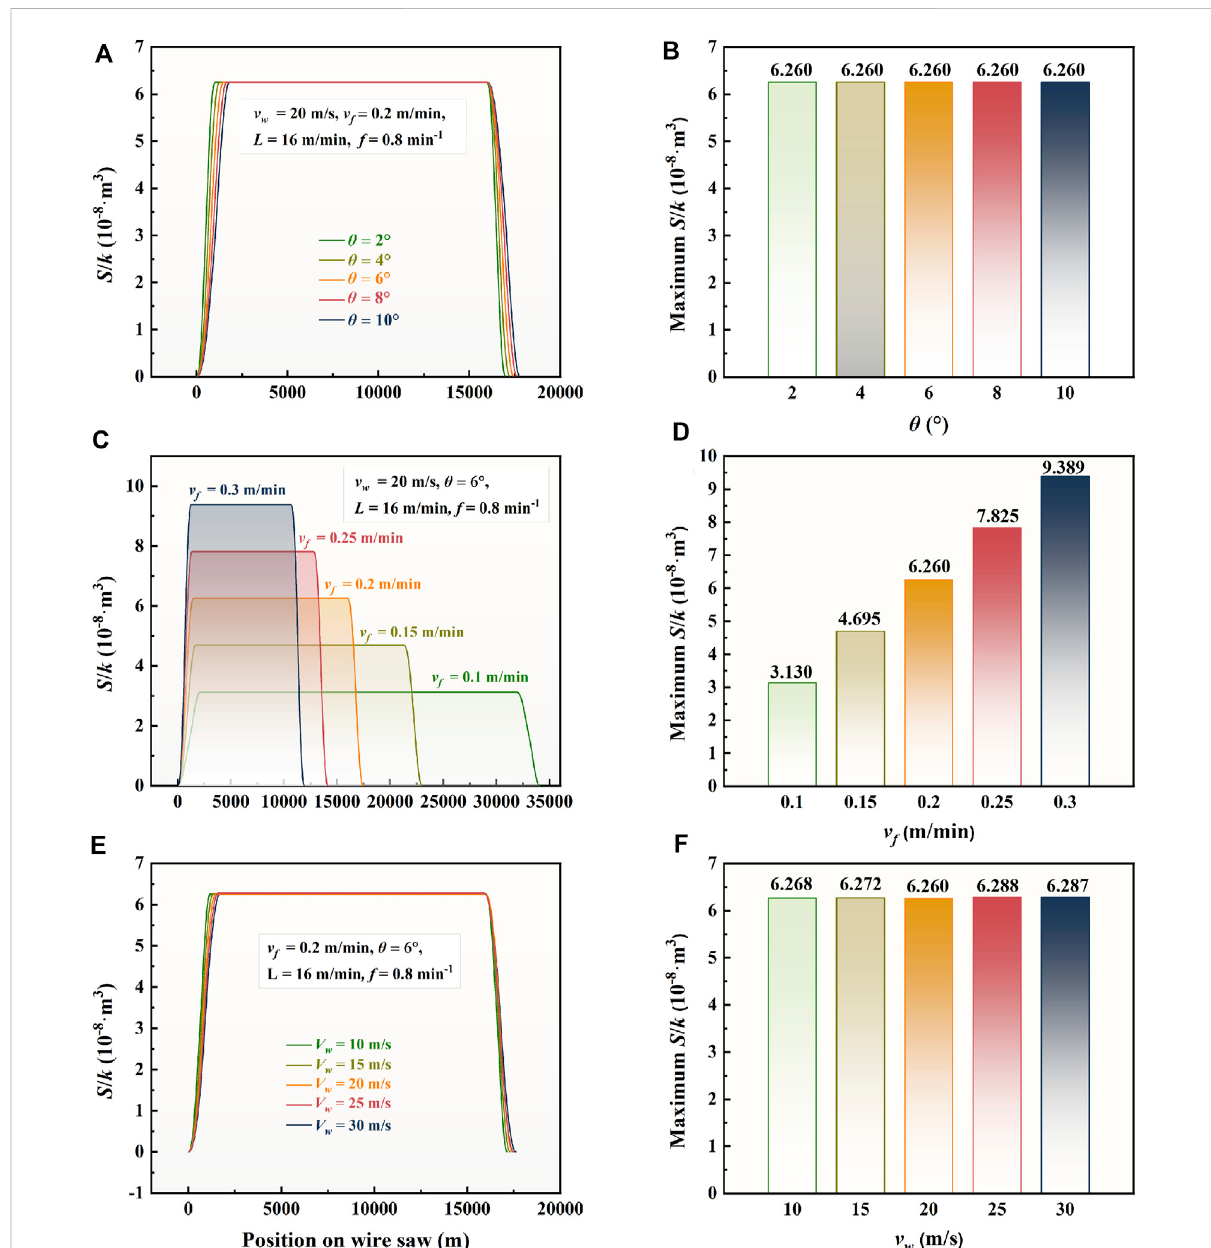
FIGURE 10 Variation of the wear amount of the wire saw on the rectangular workpiece under different maximum rocking angles, workpiece feed speeds and maximum wire speeds. Figure (A,B) illustrate the effect of the rocking angle on the maximum wear of the wire saw is not obvious, because the change ofthe angle isnot obvious to thechangeof thesawing area ineach cycle. Figure (C,D) illustrate thechange of theworkpiece feed speed has obvious changes to the maximum wear amount of the wire saw. This is because the change in the workpiece feed speed will cause the sawing area to follow the change in each cycle. Figure (E,F) illustrate the change of the wire speed has no obvious effect on the maximum wear amount of the wire